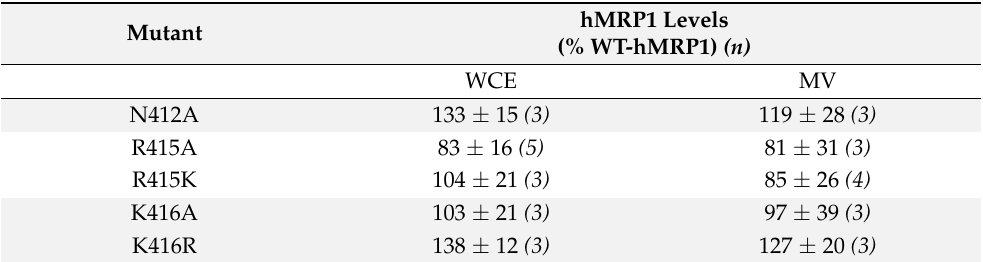
Table 1. Mutations of Asn 412 , Arg 415 , and Lys 416 within the CL4 coupling helix have no deleterious effect on hMRP1 protein expression levels. Wild-type and mutant hMRP1 expression levels were measured by immunoblotting of WCE (10 µ g) and membrane vesicles (MV) (1 µ g) prepared from transfected HEK cells. hMRP1 levels were estimated using densitometry, values normalized according to the signal of the α -tubulin loading control (for WCE) or the signal of the Na + /K + -ATPase loading control (for MV), and expressed as a percent of wild-type (WT) hMRP1 levels. Values represent the means ( ± SD) of results obtained from 3–5 independent transfections ( n